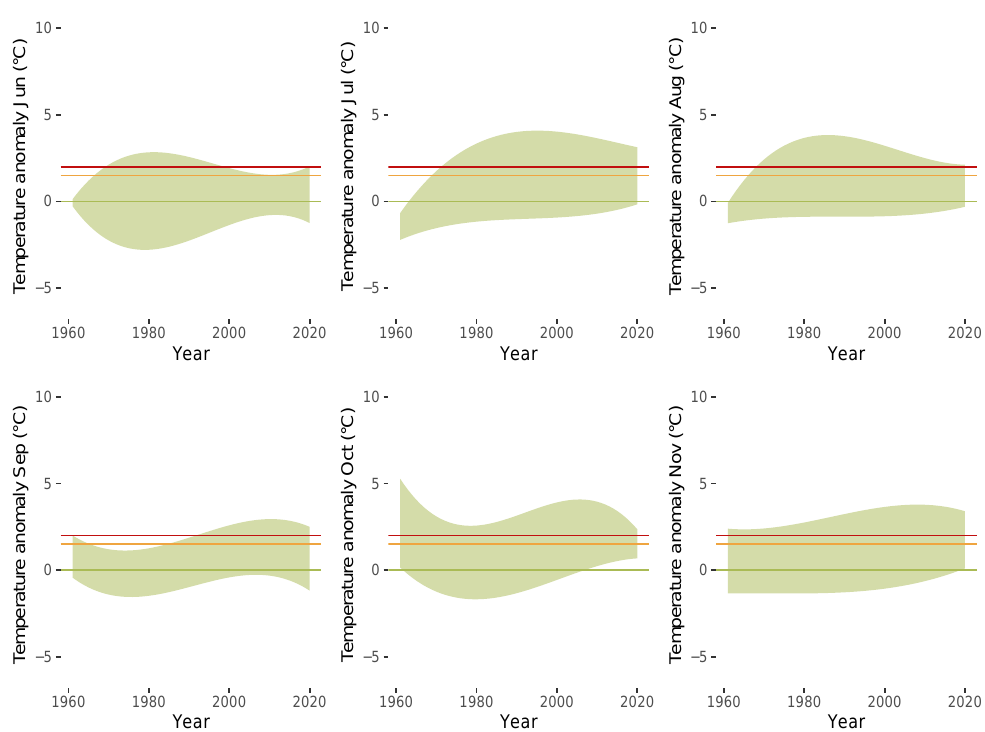
Figure 10. Anomalies for each month from January 1961 until December 2020. Green shaded area colors region between QTR models for hot ( τ = 0.95 quantile) and cold ( τ = 0.05 quantile) extremes. Horizontal lines indicate anomalies of 0 ◦ C (green), 1.5 ◦ C (orange), and 2 ◦ C